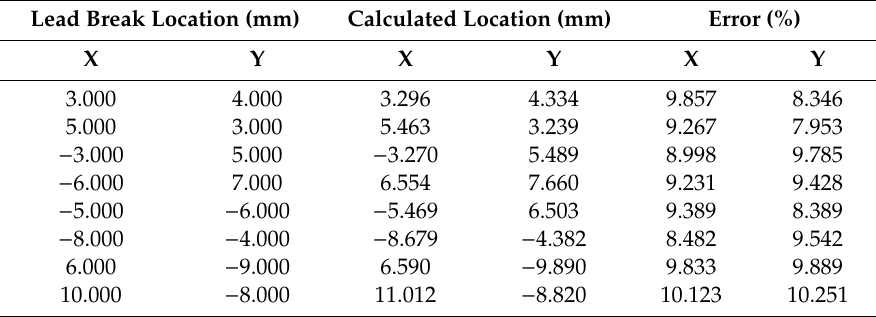
Table 2. Comparison of the actual location of AE source with the calculated location of four-point circular